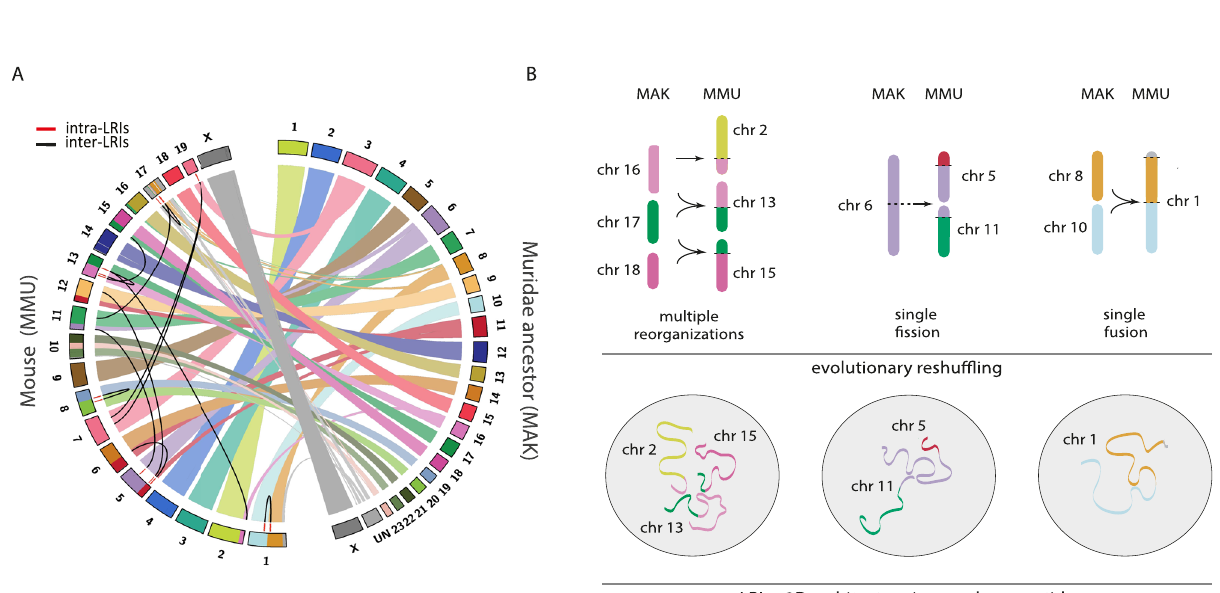
Fig. 5 Long-range genomic interactions and ancestral chromosomal con fi gurations. A Pairwise circus plot comparing the syntenic regions between the mouse karyotype and the Muridae ancestor karyotype (MAK). Inter-LRIs are depicted in black and intra-LRIs in red. Chromosomes are colour code according to the Muridae ancestor. B Upper panel - Schematic representation of the different types of evolutionary rearrangements from the Muridae ancestral karyotype including: single fusions, single fi ssions and complex reorganisations. Lower panel - Schematic representation of the 3D architecture of LRIs found in round spermatids according to the different types of evolutionary rearrangements. Chromosomes are colour code according to the Muridae ancestor. Abbreviations – LRIs long-ranged interactions, MAK Muridae ancestor karyotype, MMU Mus musculus domesticus, chr